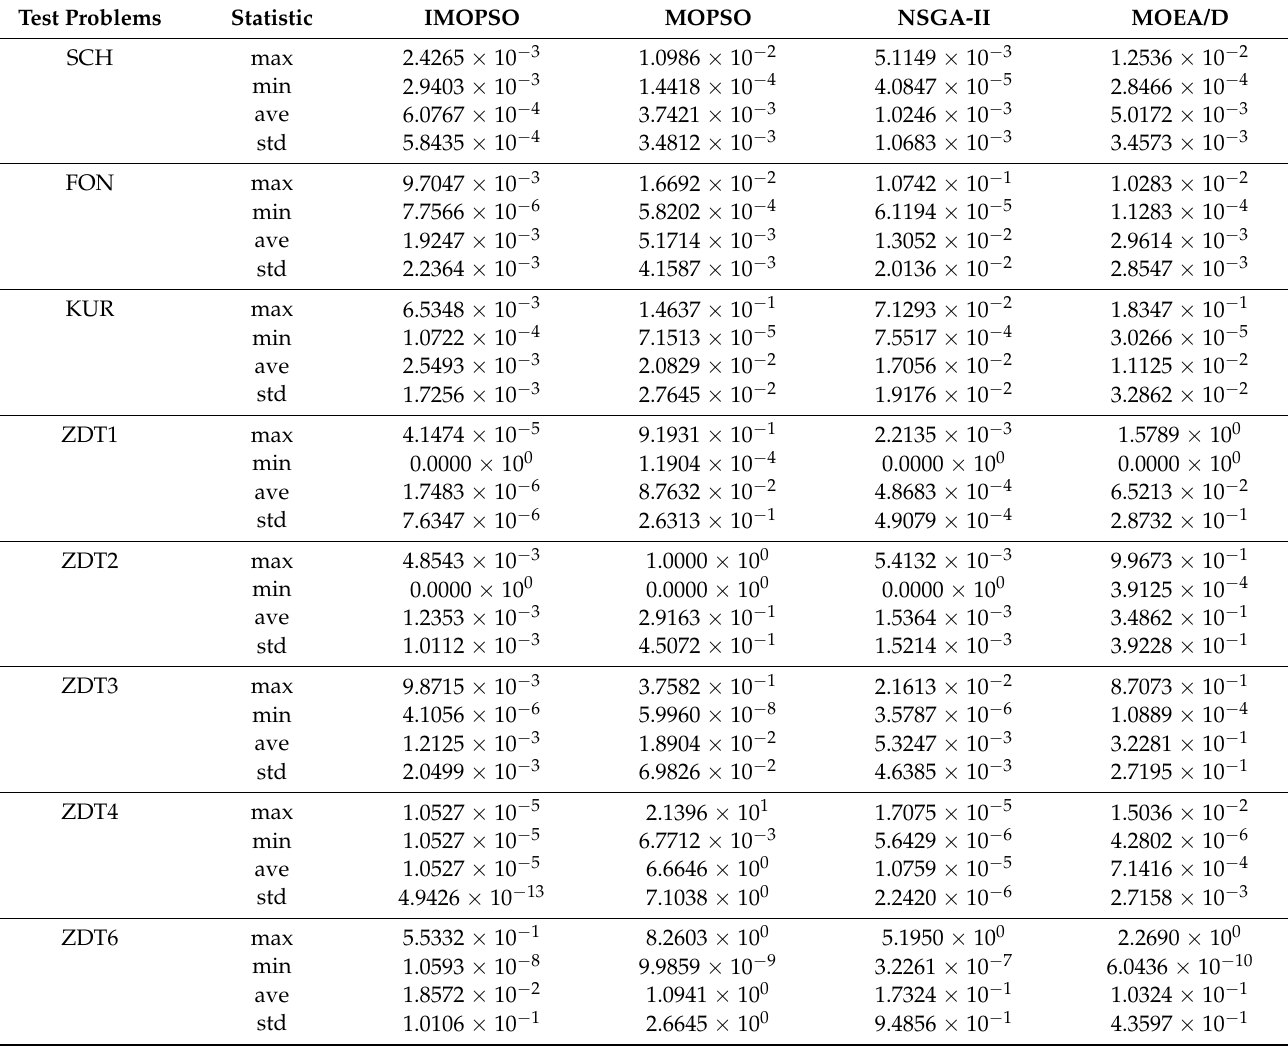
Table 4. Comparison of the DW index of four algorithms.